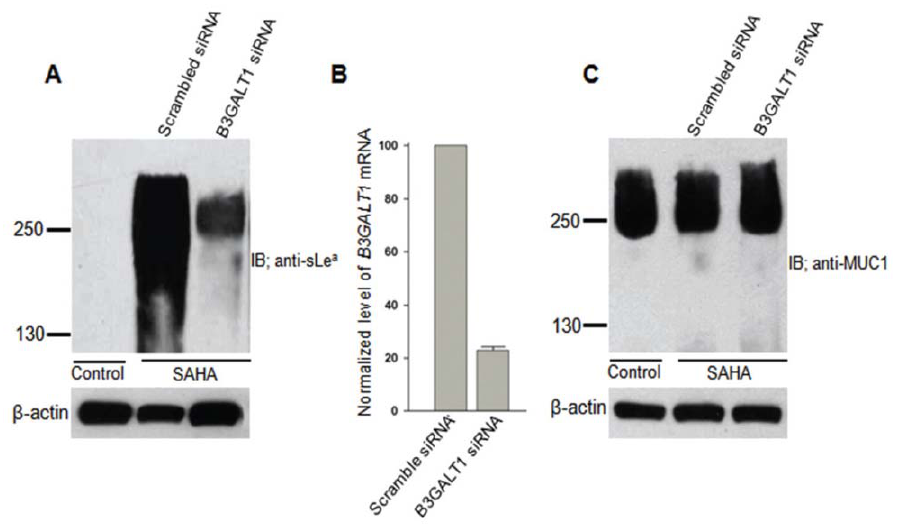
Figure 7. Knockdown of B3GALT1 mRNA reduces sLe a in SAHA-treated RWPE-1 cells. (A) Anti-sLe a western blot of the lysates of control cells, SAHA plus scrambled siRNA, or SAHA plus B3GALT1 siRNA. (B) Knockdown of B3GALT1 gene in RWPE-1 cells was confirmed by 77% reduction of B3GALT1 mRNA measured by quantitative real-time PCR analysis. Relative expression level of B3GALT1 gene was determined according to D Ct method (see materials and methods) after normalization with GAPDH (=100%) and then expressed as % of B3GALT1 mRNA relative to same in the control (=100%) (n=3). (C) Anti-MUC1 western blot of the lysates of cells treated with SAHA, SAHA plus scrambled siRNA, or SAHA plus B3GALT1 siRNA. Knockdown of 77% of B3GALT1 mRNA reduces sLe a in SAHA-treated RWPE-1 cells without affecting MUC1 glycoprotein. Experiments were performed (3x) with similar results.